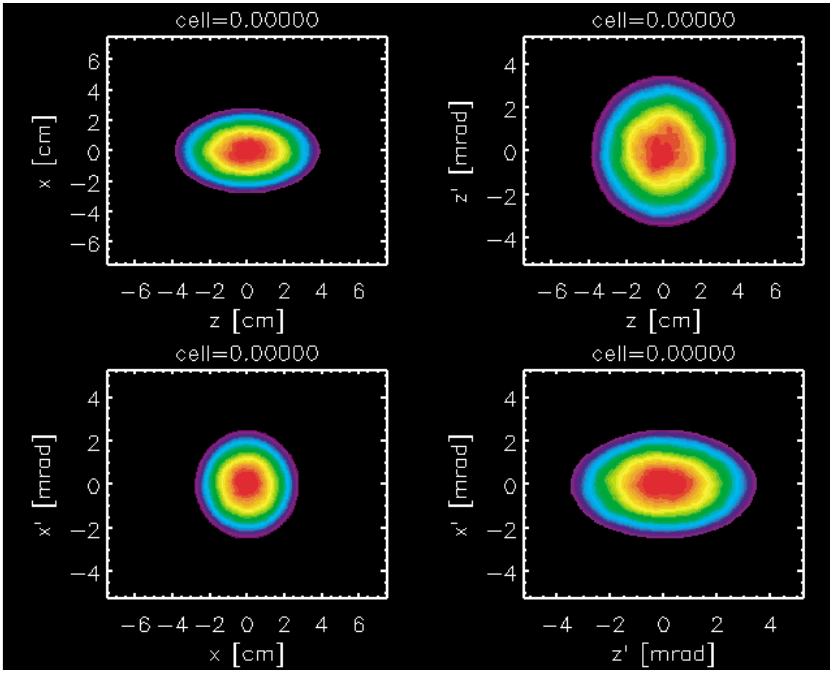
VIDEO 1.Animated results from computer simulation of the WB case of Fig. 7 showing the emittance exchange evolution over 30 periods. Shown are scatter plots in (cid:1) z; x (cid:2) , (cid:1) z; z 0 (cid:2) , and (cid:1) x; x 0 (cid:2) evolving in time, where 1 cell corresponds to 0.3 periods of Fig. 7. Red indicates maximum point density, and black zero point density.